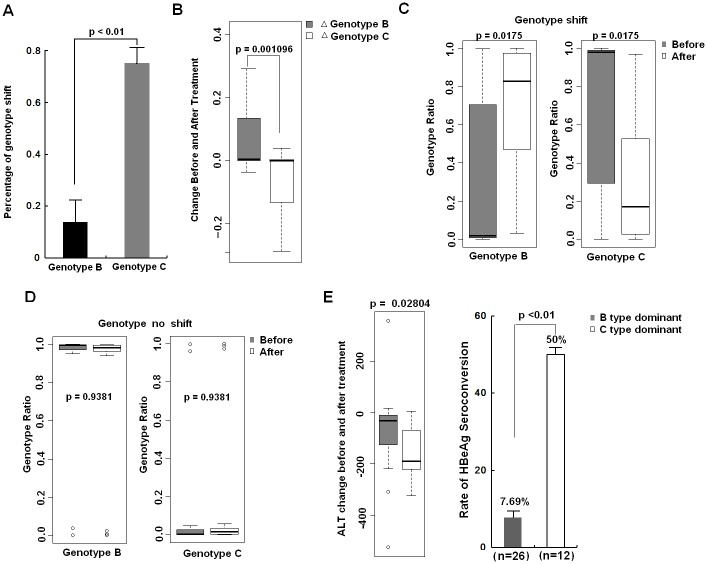
HBV genotype C was more sensitive to ADV than genotype B.(A) 38 patients were divided into genotype B group and genotype C group based on the genotype before ADV treatment analyzed by Sanger sequencing. Patients with genotype C showed higher rate of genotype shift than genotype B after ADV treatment. (B) The change of genotype B and C ratios in 38 patients before and after ADV treatment analyzed by deep sequencing method. ΔGenotype B = Genotype B ratio after ADV treatment- Genotype B ratio before ADV treatment; ΔGenotype C = Genotype C ratio after ADV treatment- Genotype C ratio before ADV treatment. (C) Genotype shift (GS) group showed increased ratio of genotype B accompanied by decreased ratio of genotype C after ADV treatment (p = 0.0175). (D) Group without genotype shift (NS) showed no significant difference of genotype B or C ratio after ADV treatment (p = 0.9381). (E) Comparison of change in ALT and the rate of HBeAg seroconversion after ADV therapy between patients with dominant genotype B and C. B, C, D and E, 38 patients were divided into genotype B group and genotype C group based on the genotype analyzed by deep sequencing method before ADV treatment.